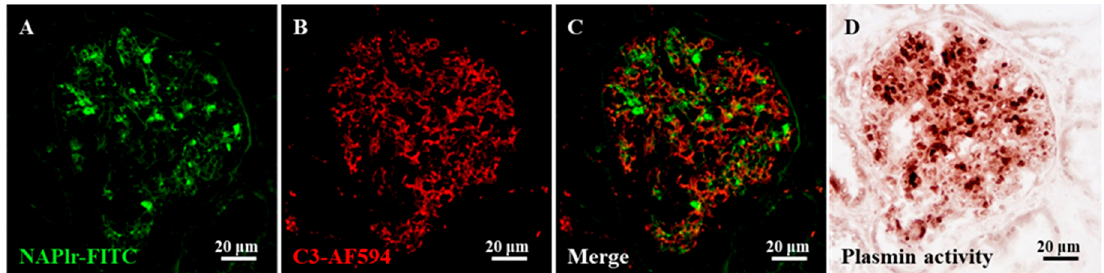
Figure 2. Representative photomicrographs of the histological staining for C3, nephritis-associated plasmin receptor (NAPlr), and plasmin activity in the glomeruli of a post-streptococcal acute glomerulonephritis (PSAGN) patient. ( A – C ) Double immunofluorescence (IF) staining for NAPlr (fluorescein isothiocyanate, green) and complement C3 (Alexa Fluor 594, red). Both NAPlr ( A ) and C3 ( B ) were positive in the glomeruli, but they generally were not colocalized, as shown in the merged image ( C ). ( D ) Plasmin activity assessed by in situ zymography on a serial section was found to be positive, and to have a similar distribution to the NAPlr staining in the glomeruli. Details of all staining methods have been described previously [11].